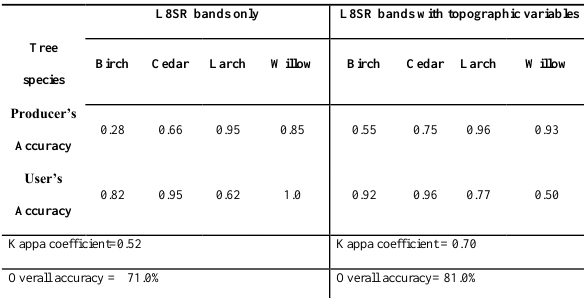
Table 2. Accuracy assessment results for classification map using L8SR bands only and L8SR bands coupled with topographic